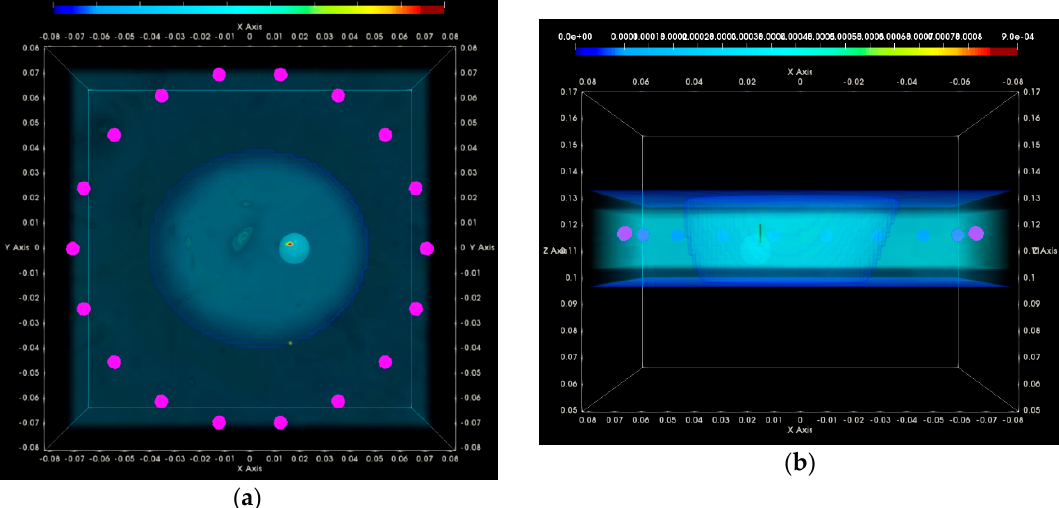
Figure 24. Breast rotational position #1—Test Date 1—image formed using six vertical positions of the sensor network in the vicinity of the tumor—image in the interior of the breast superimposed with the image of the full imaging domain: ( a ) top XY view; ( b ) side XZ view.